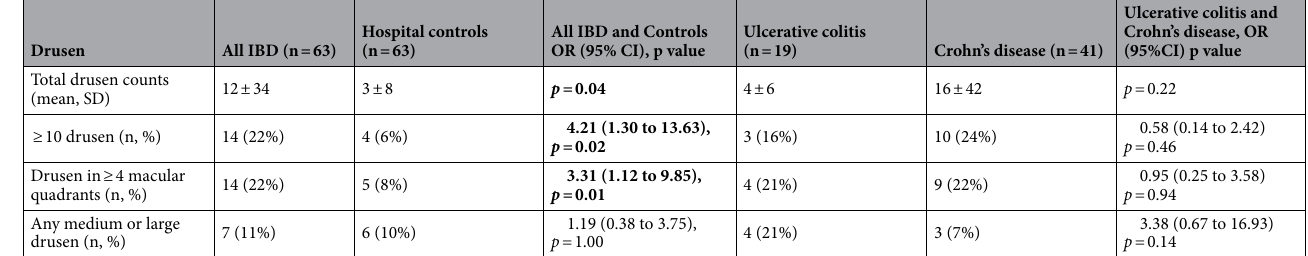
Table 2. Drusen counts, location and size in all IBD, controls, and ulcerative colitis or Crohn’s disease. Significant values are in